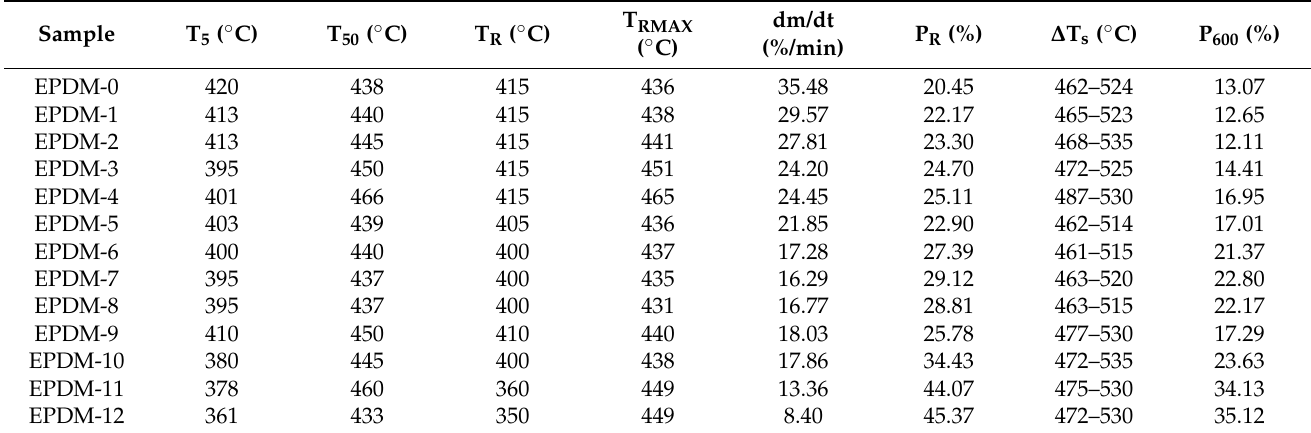
Table 2. Thermal parameters of the EPDM rubber